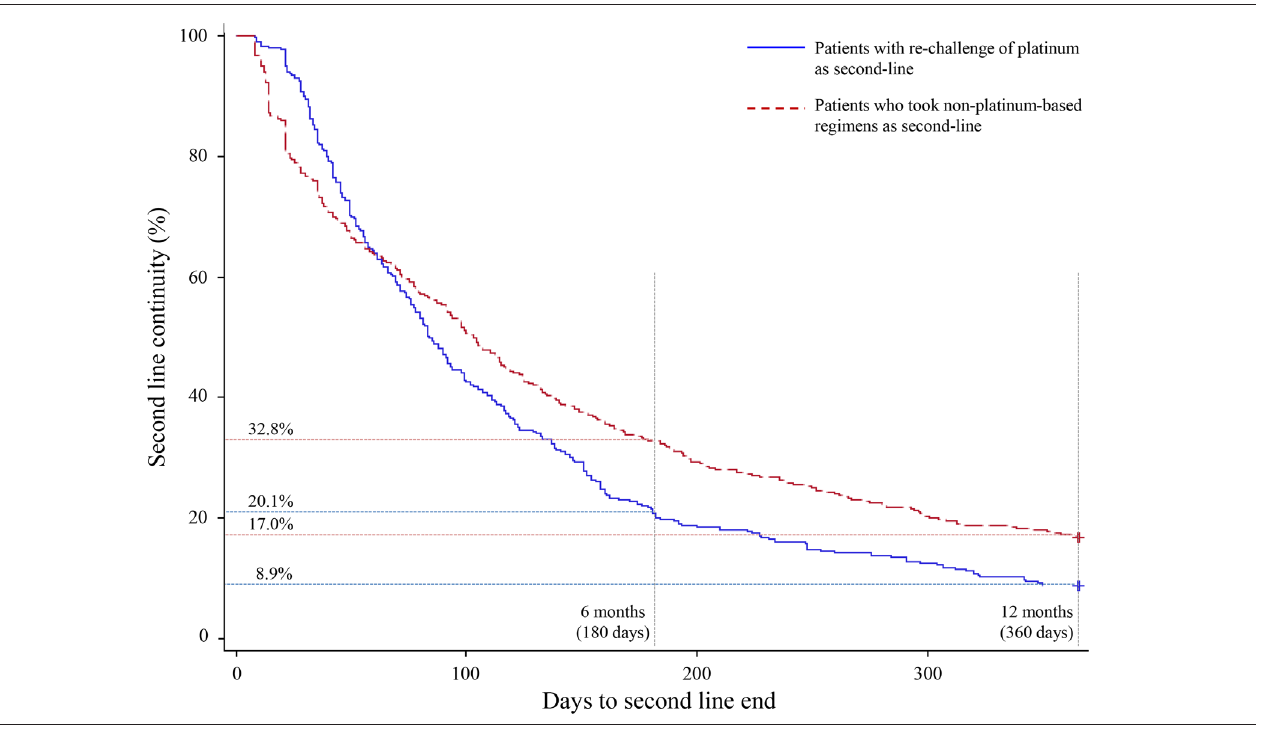
Figure 7. Kaplan–Meier Estimate of Treatment Continuation Rate for Platinum Rechallenge and Treatment Without Platinum